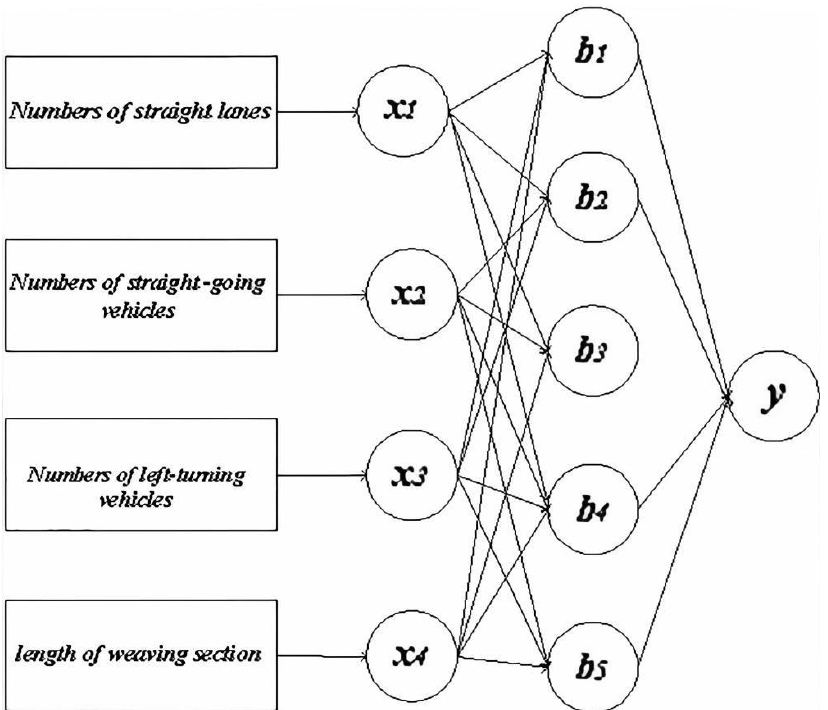
Figure 3. BP neural network structure diagram.